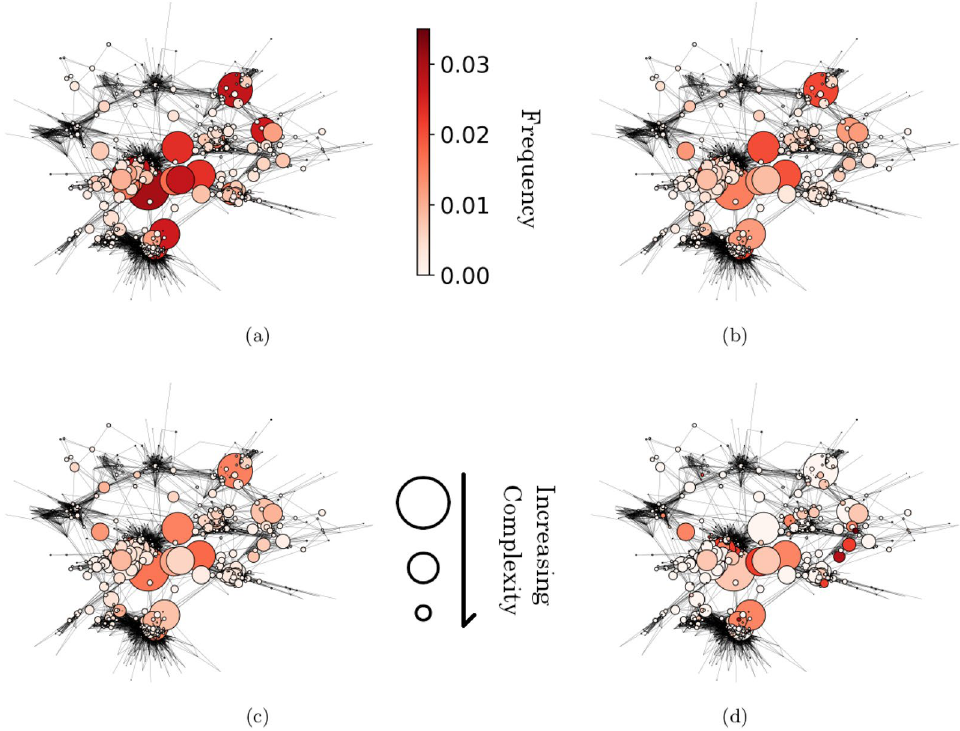
Figure 4. Complexity of openings. ( a ) The average opening repertoire of low-rated chess players is visualized using the opening network. We selected all players with ratings between 1500 and 1600. For each opening, we computed its frequency of use. Dark colors represent frequently used openings, while light colors represent infrequently used ones. The size of nodes is inversely proportional to the openings’ complexity, so small nodes represent hard-to-play openings, while big nodes represent easy-to-play openings. We observe that low-rated players frequently use low-complexity openings. ( b ) Same analysis for players with ratings between 1900 and 2000. ( c ) Same analysis for players with ratings between 2300 and 2400. ( d ) Same analysis for the opening repertoire of world champion Magnus Carlsen. As a player’s rating increases, low complexity openings tend to be used less frequently, while the frequency of more complex openings